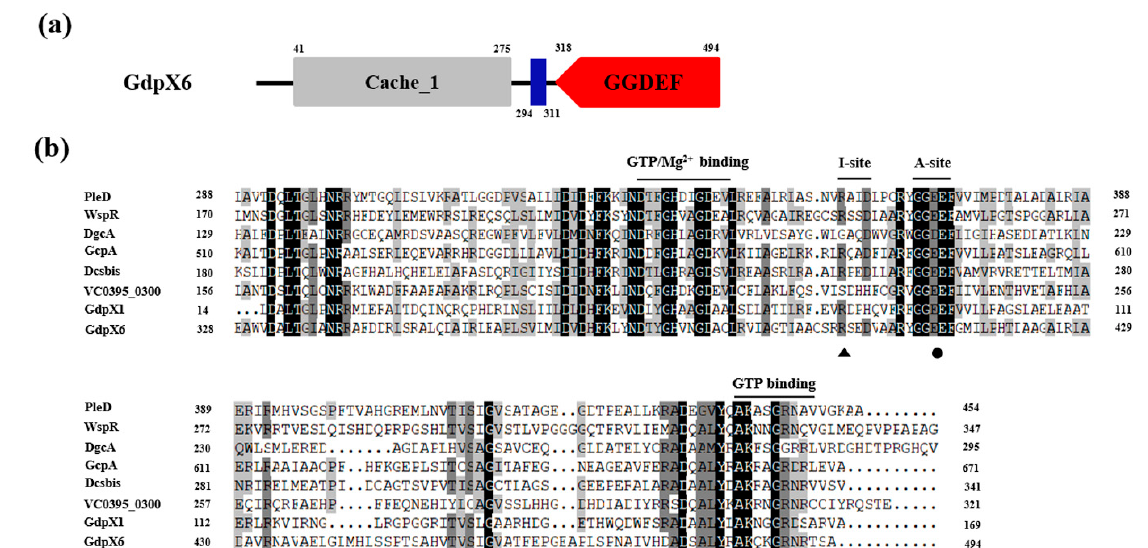
Figure 1. Domain organization and sequence alignment of GdpX6. ( a ) Schematic representation of the domain structures of GdpX6 (GenBank accession no. WP_012445692.1). The numbers represent the start and end amino acid of the predicted domains based on National Center for Biotechnology Information’s (NCBI’s) conserved domain database and SMART database. The Cache_1 domain (gray), transmembrane domain (blue) and GGDEF domain (red) are shown. ( b ) The amino sequence alignment of the GGDEF domain of GdpX6 with active DGCs, including PleD (GenBank accession